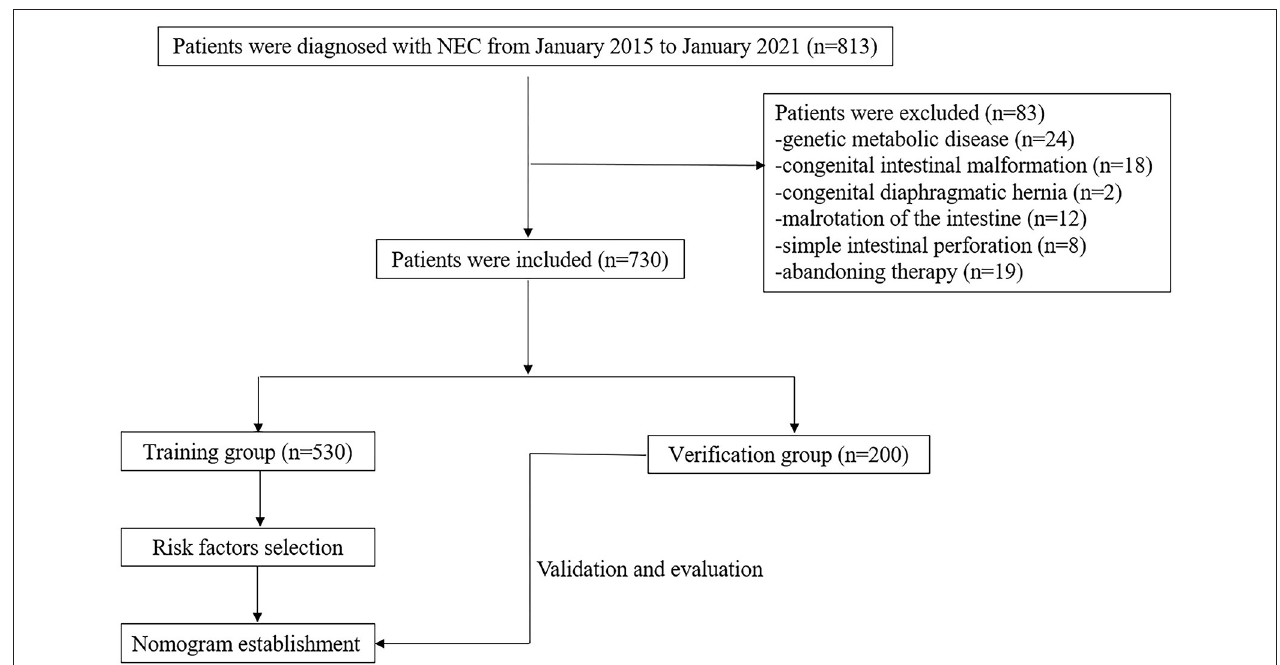
FIGURE 1 | Flowchart of patients included and excluded from the